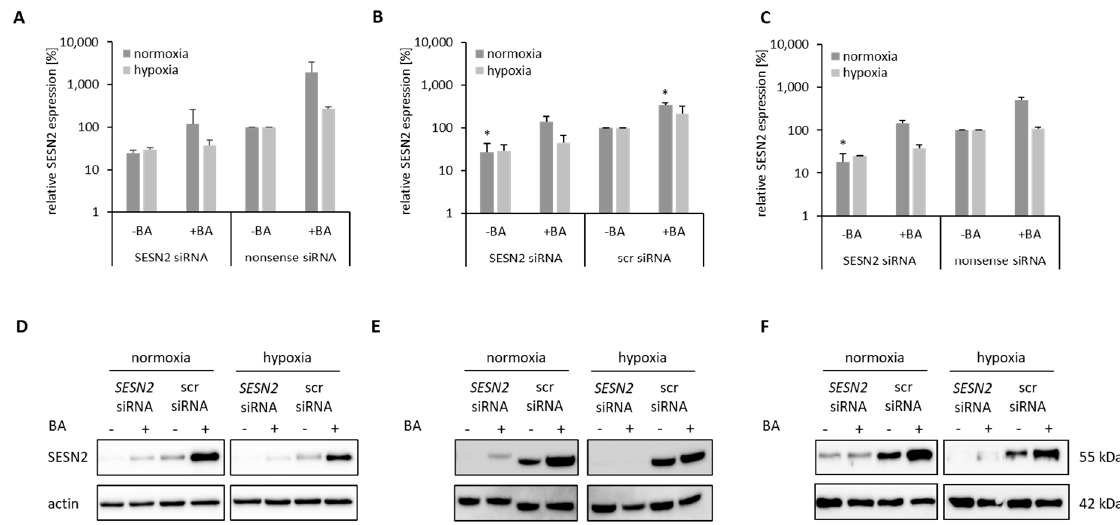
Figure 5. Knockdown of SESN2 expression in human breast cancer cells. Breast cancer cells were transfected with siRNA against SESN2 and additionally treated with 20 μ M BA for another 24 h under normoxic and hypoxic conditions. A ‐ C. qRT ‐ PCR: Effective SESN2 knockdown is shown without and after BA treatment in MDA ‐ MB ‐ 231 ( A ), HS578T ( B ) and MCF ‐ 7 ( C ) cell line. Data represent mean values (+SD) of at least three independent experiments. Significant p values are highlighted with asterisks (* p ≤ 0.05). D ‐ F. Western blot of MDA ‐ MB ‐ 231 ( D ), HS578T ( E ) and MCF ‐ 7 ( F ) cells: BA treatment induced SESN2 (55 kDa) protein level, which is prevented by SESN2 knock ‐ down. A representative blot is shown and Actin (42 kDa) is used as a loading control. src siRNA – scrambled siRNA.